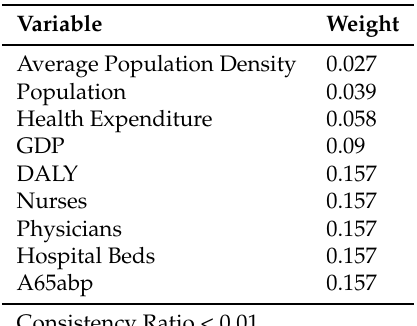
Table 1. Base scenario weights of static factors.